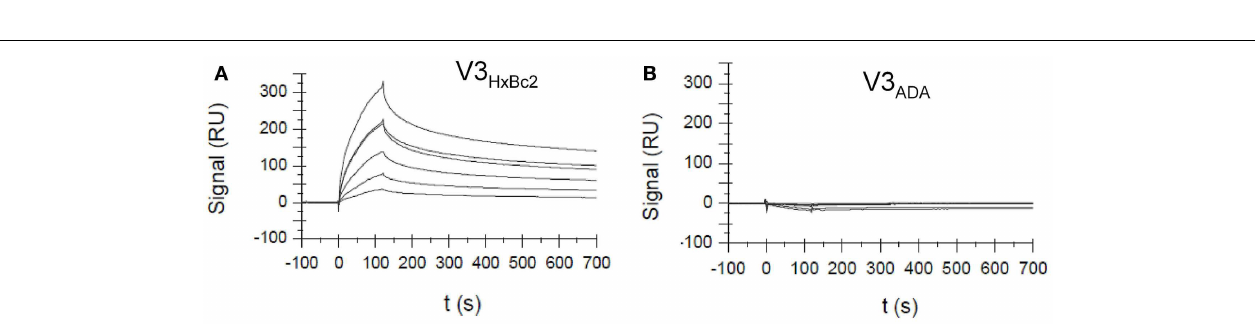
FIGURE 5 | Surface Plasmon resonance sensograms for the interaction of the CXCR4 mimetic peptide CX4-M1 withV3 loop peptides from X4 tropic (HxBc2) (A) and R5-tropic (ADA) (B) HIV-1 . See Section “Materials and Methods” for experimental